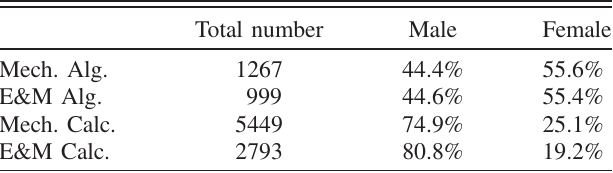
TABLE I. Number of students and their gender distribution for each of the four introductory courses from the algebra- and calculus-based sequences.